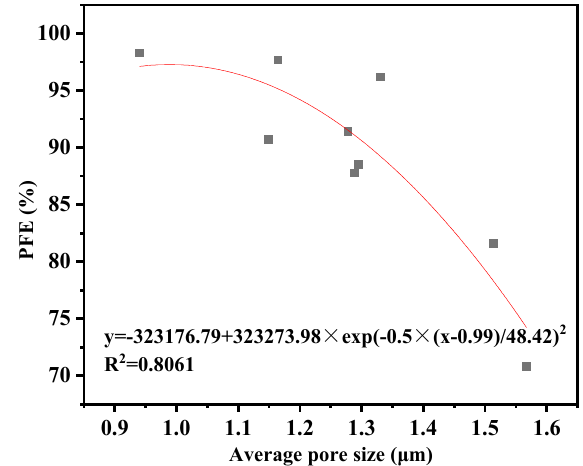
Figure 5. Correlation of pore size and PEF.